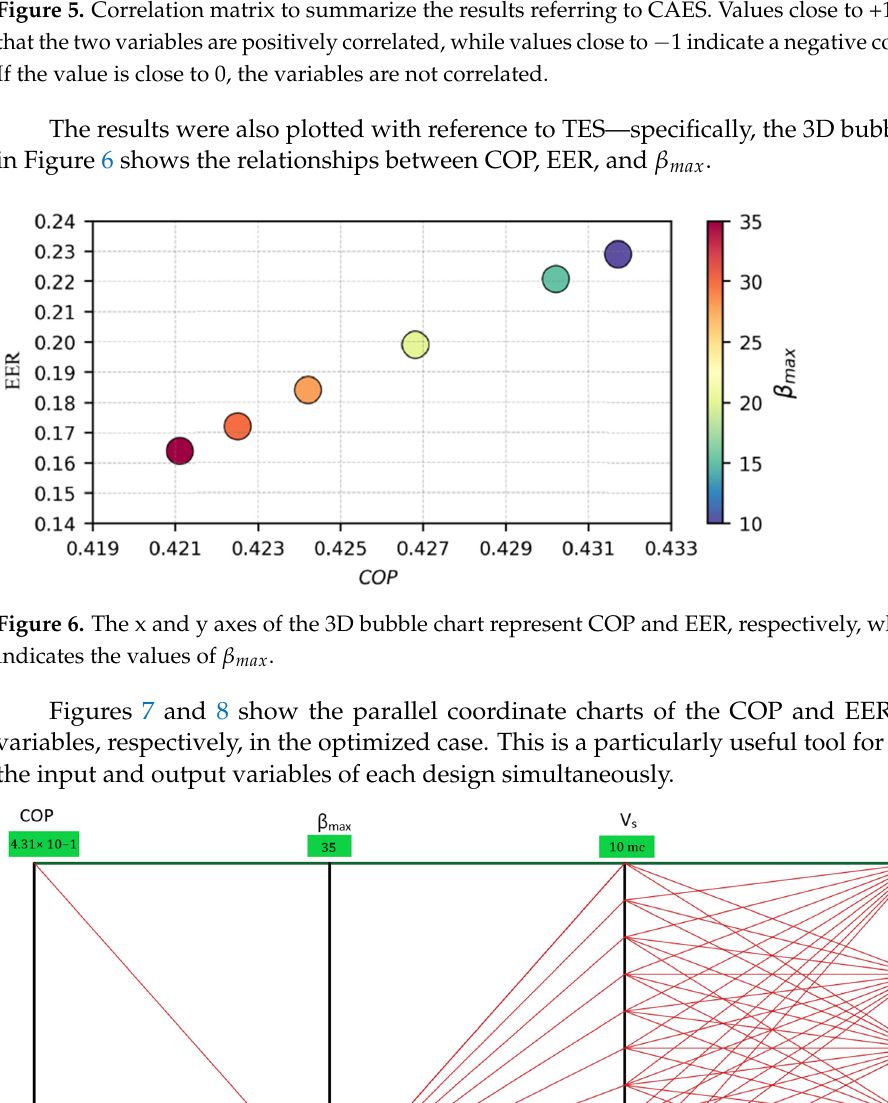
Figure 5. Correlation matrix to summarize the results referring to CAES. Values close to +1 indicate